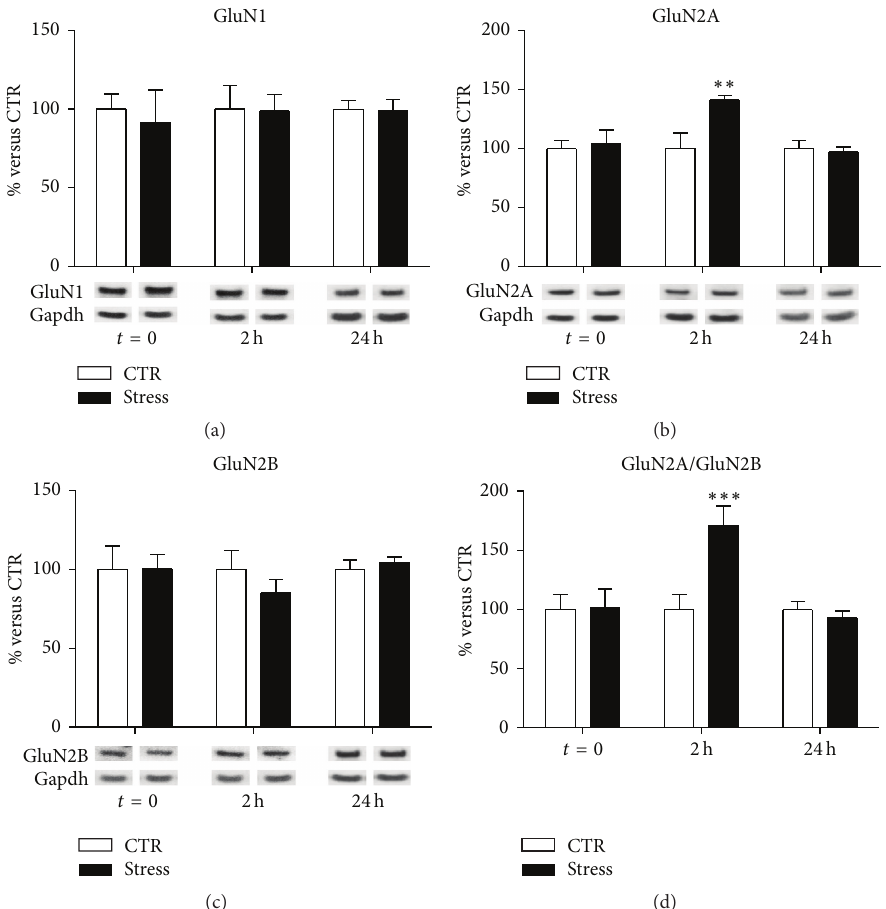
Figure 3: Time-dependent changes of protein expression levels of GluN1 (a), GluN2A (b), GluN2B (c), and GluN2A/GluN2B (d) in PFC/FC total homogenate of rats subjected to FS-stress and sacrificed immediately after stress and 2 h and 24h from stress beginning. Data are representedaspercentageofcontrolsateachtimepoint,asmeans ± SEM( 𝑛 = 8 ).Statistics:GeneralizedLinearModels(GLM)andBonferroni Post Hoc Test (see Section 2 for details). ∗∗ 𝑝 < 0.01 ; ∗∗∗ 𝑝 < 0.001